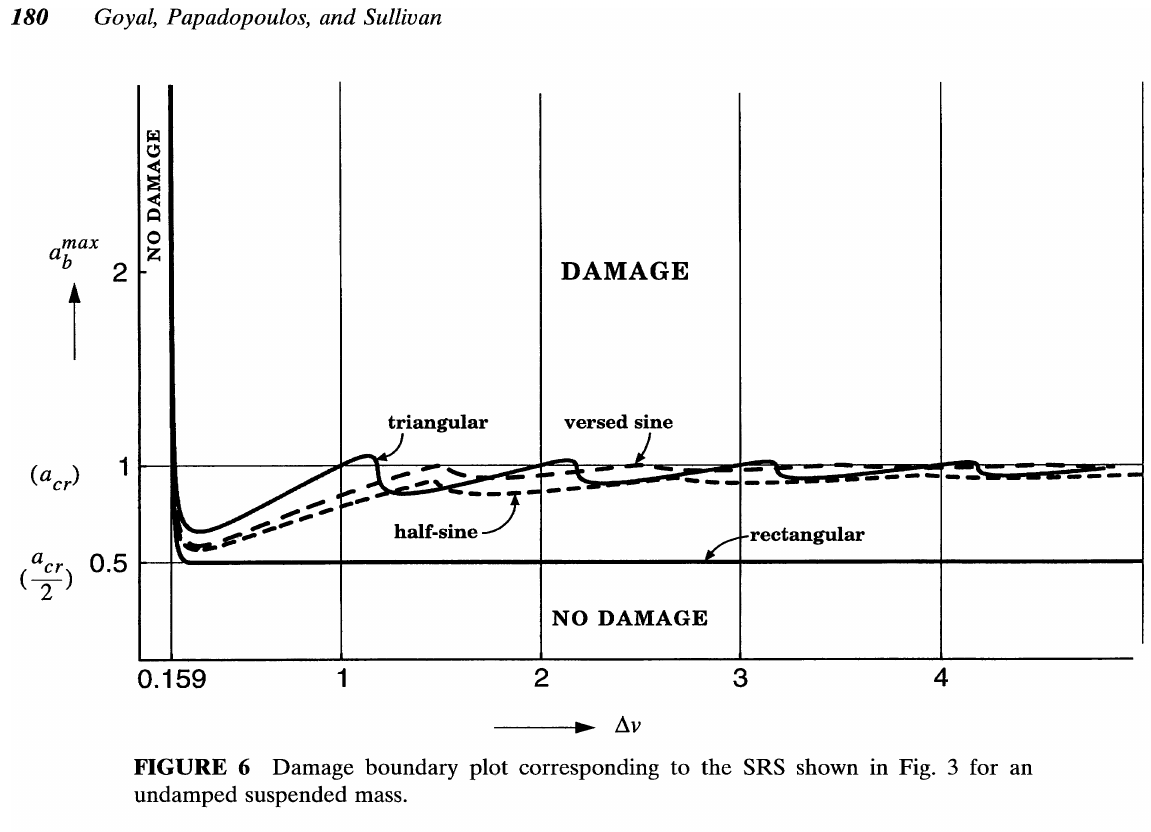
FIGURE 6 Damage boundary plot corresponding to the SRS shown in Fig. 3 for an undamped suspended